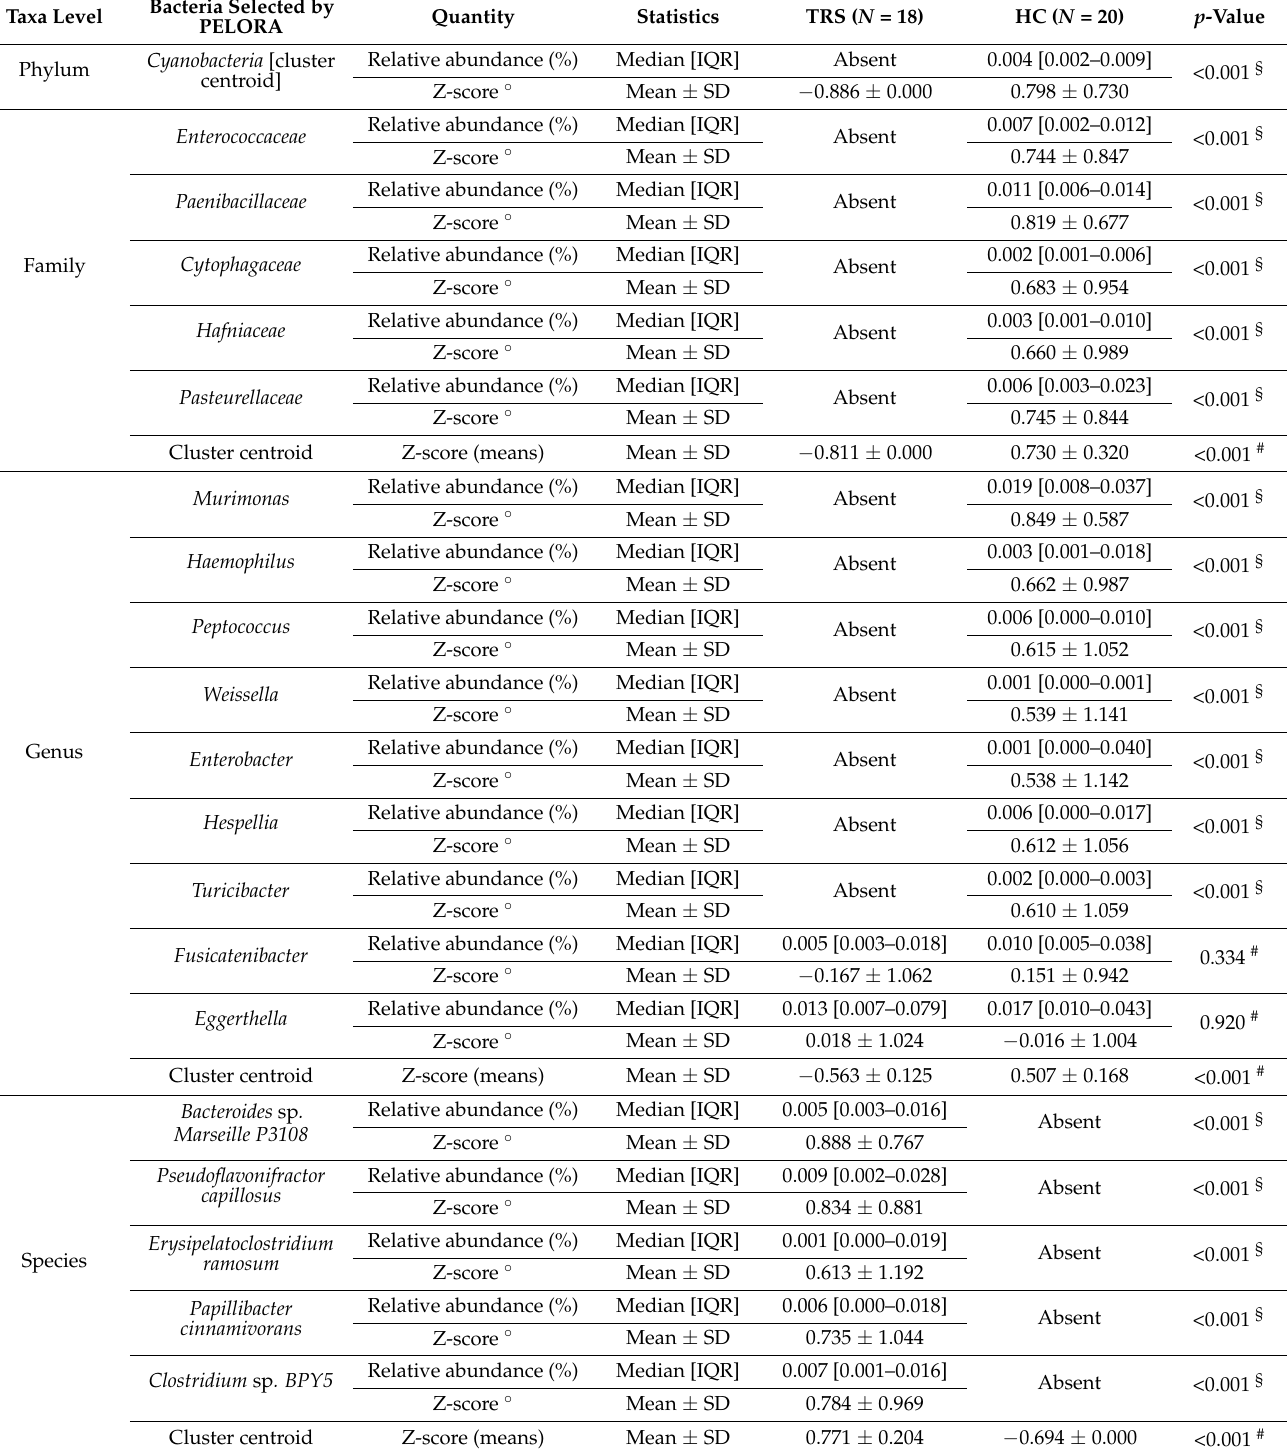
Table 5. Results from Penalized Logistic Regression Analysis (PELORA) algorithm which identifies panels of bacterial populations that best discriminate TRS from